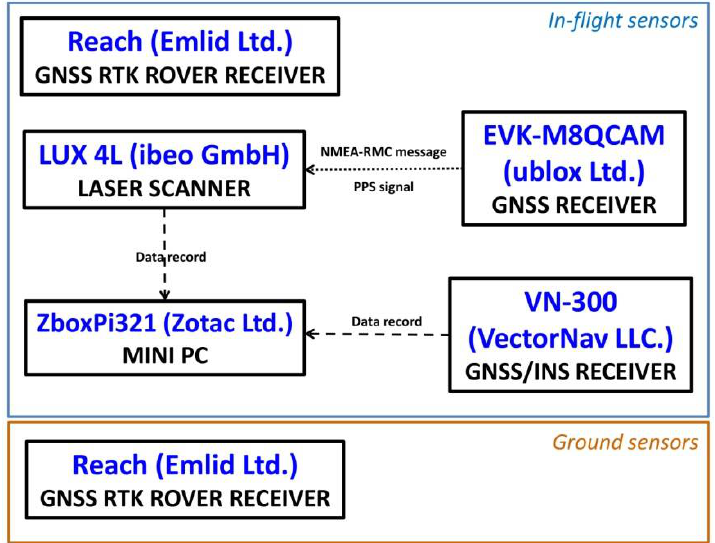
Figure 2. The architecture of the LiDAR system. The GNSS receiver sends a PPS signal in NMEA-RMC format to the laser scanner; laser scanner and GNSS/INS data are recorded in a mini PC, while GNSS RTK data are directly registered in the cards of the receivers.